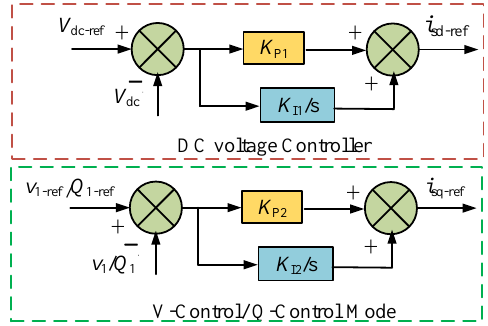
Figure 4. Outer loop controller of the STATCOM power controller.